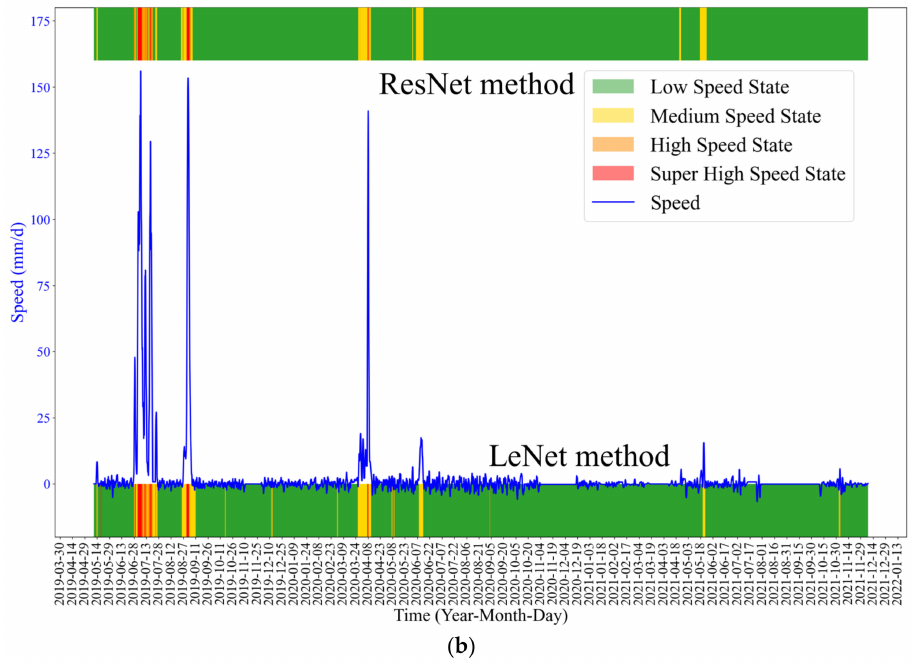
Figure 11. Results of ( a ) MLP methods and ( b ) LeNet methods.